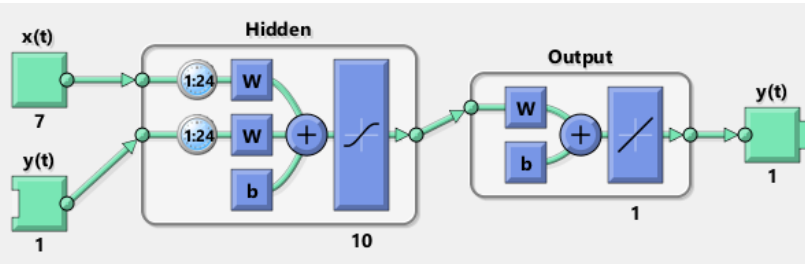
Figure 3. MATLAB NARX network